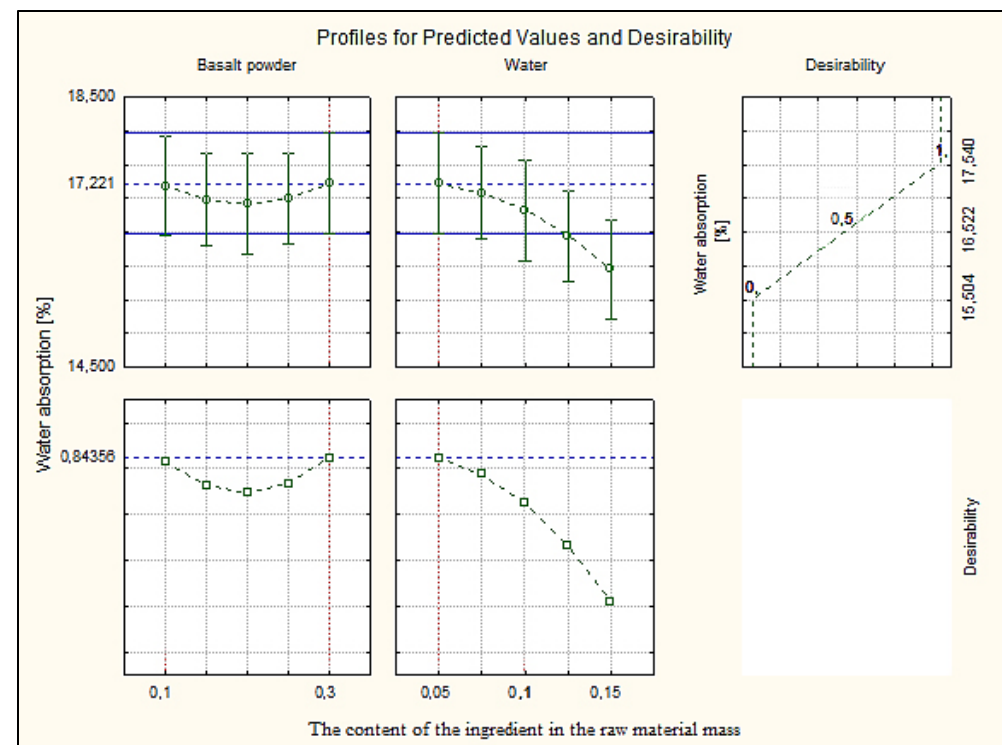
Figure 19. Profiles for predicted value and desirability for water absorption.